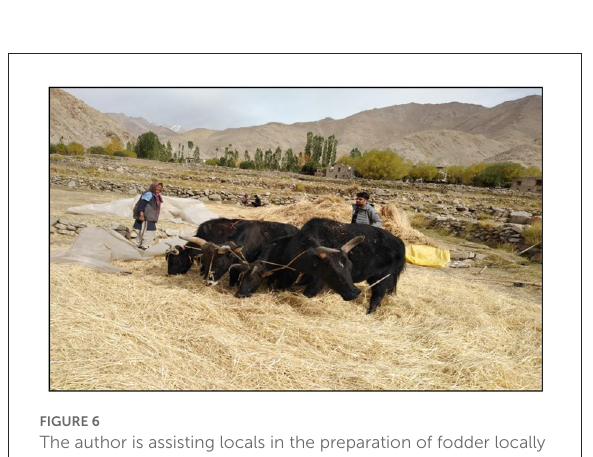
FIGURE6 The author is assisting locals in the preparation of fodder locally called as ( Phungma ) from Hordeum vulgare in the Ladakh